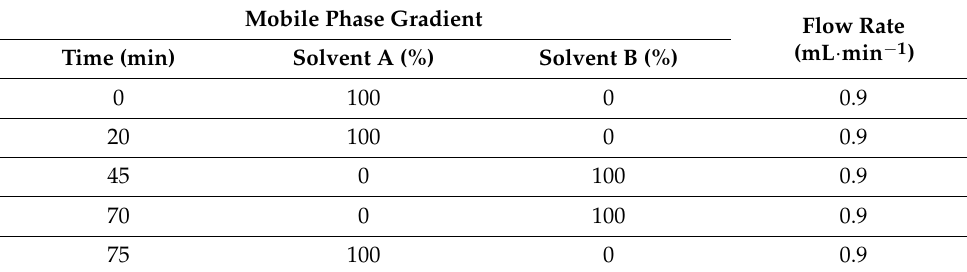
Table 7. Phase gradient used in the HPLC